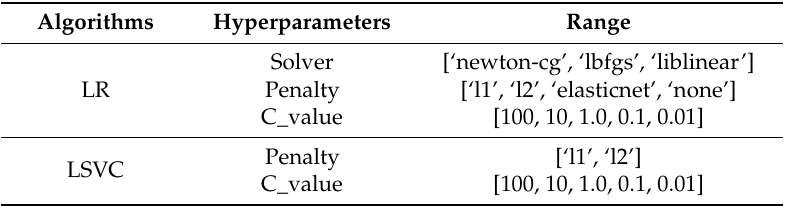
Table 6. Hyperparameters tuning range.